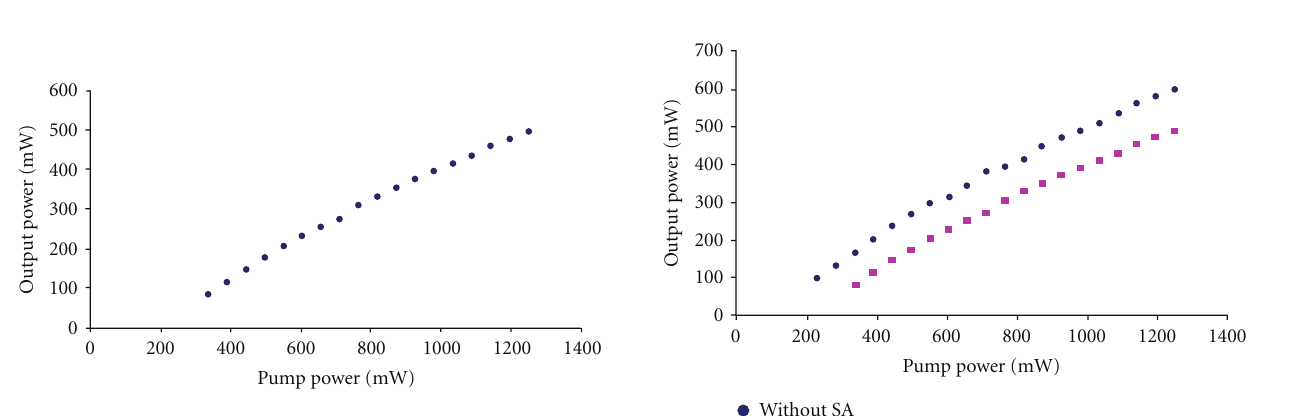
Figure 6: Input-output characteristics of the laser with 5m of SA inside the cavity at λ = 1565 . 52 nm. Figure 7: Input-output characteristics of the laser with and without